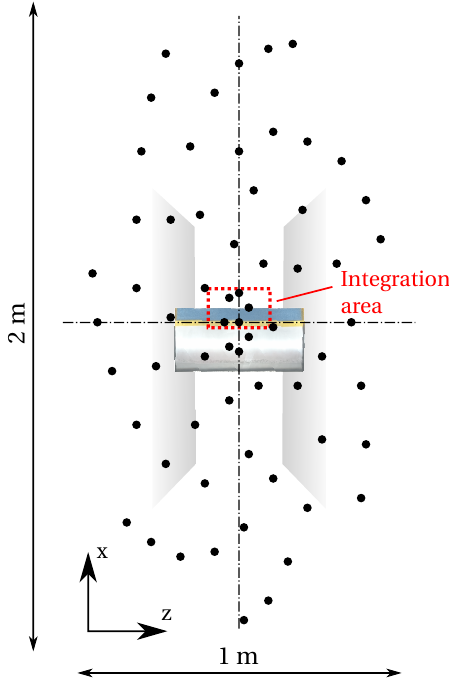
Figure 4. Microphone array setup and location of integration area.